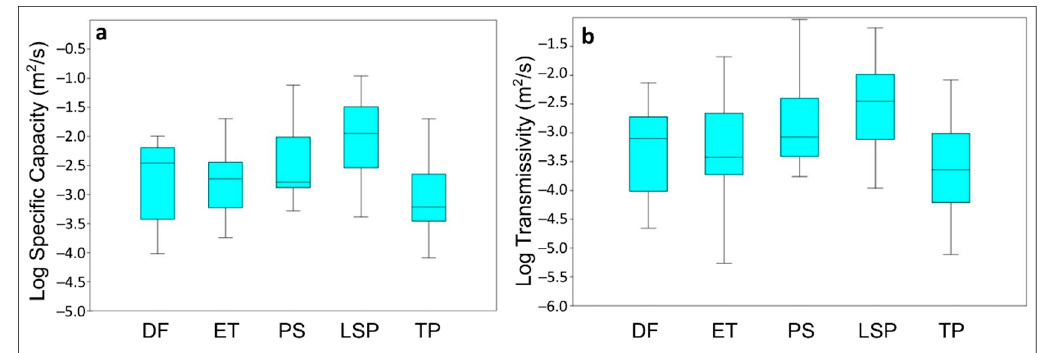
Figure 5. Box-and-whisker diagrams of the log-transformed values of specific capacity ( a ) and transmissivity ( b ) for the different types of aquifer formation (for the abbreviations see the text).